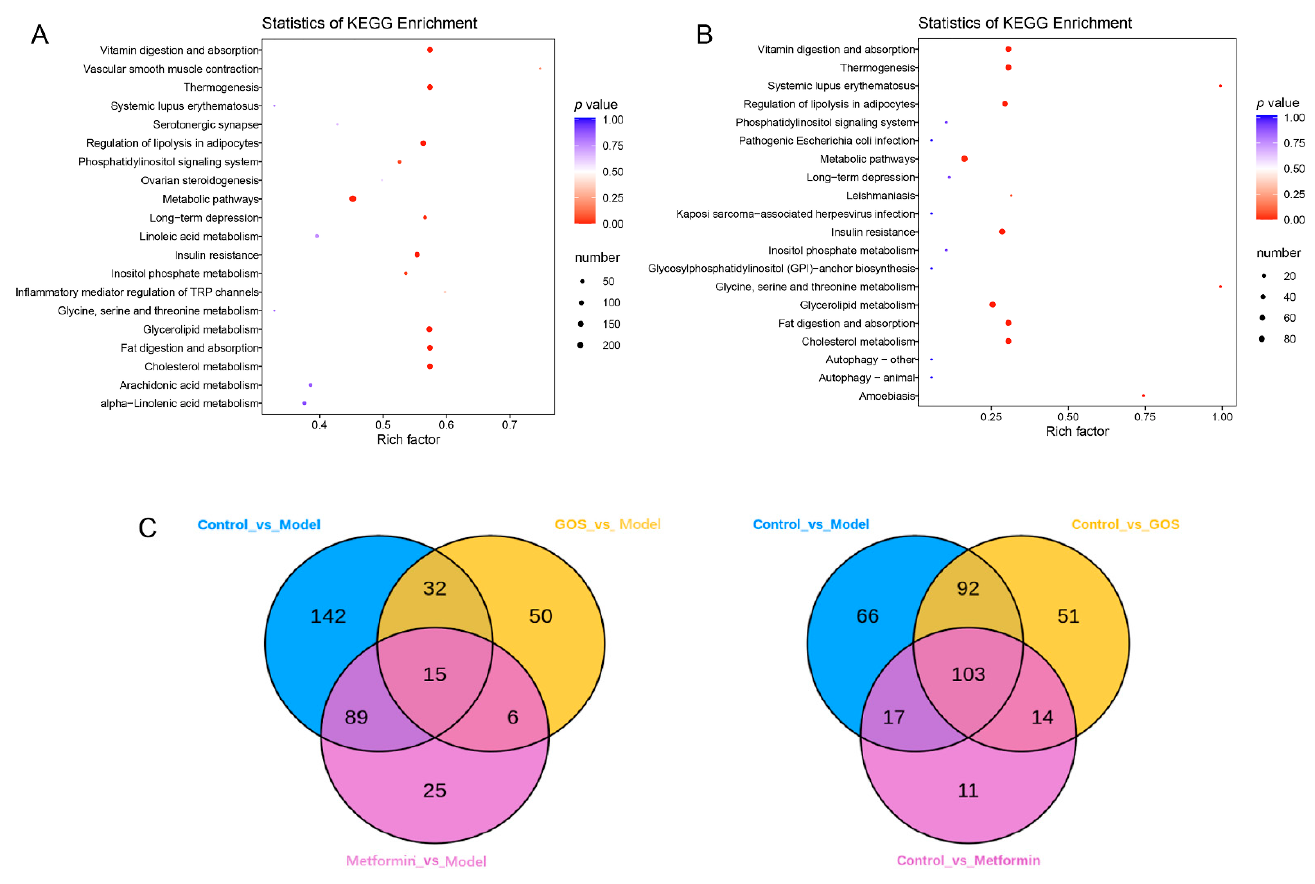
Figure 6. ( A ) Metabolite KEGG enrichment diagram of liver tissue samples in control and model. ( B ) Metabolite KEGG enrichment diagram of liver tissue samples in GOS and model. Venn diagram of metabolites in different groups where the Rich Factor was the ratio of the number of metabolites in the corresponding pathway to the total number of metabolites annotated by the detection of that pathway. The larger the value was, the greater the enrichment degree was. ( C ) Venn diagram of metabolites in different groups.